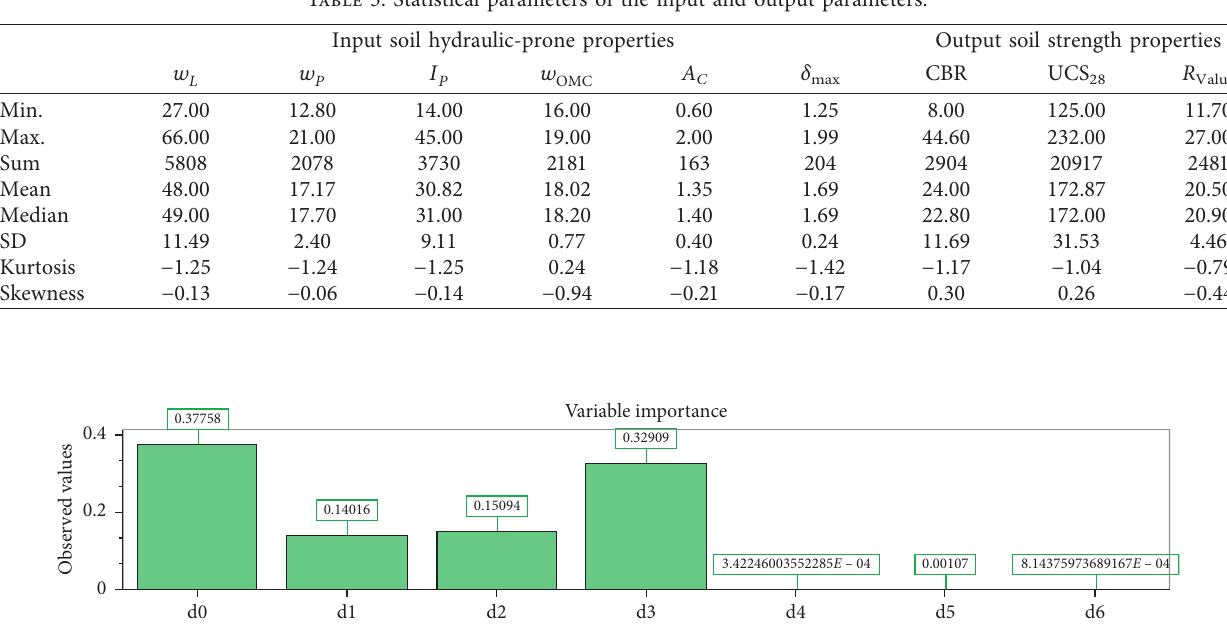
Table 3: Statistical parameters of the input and output parameters.